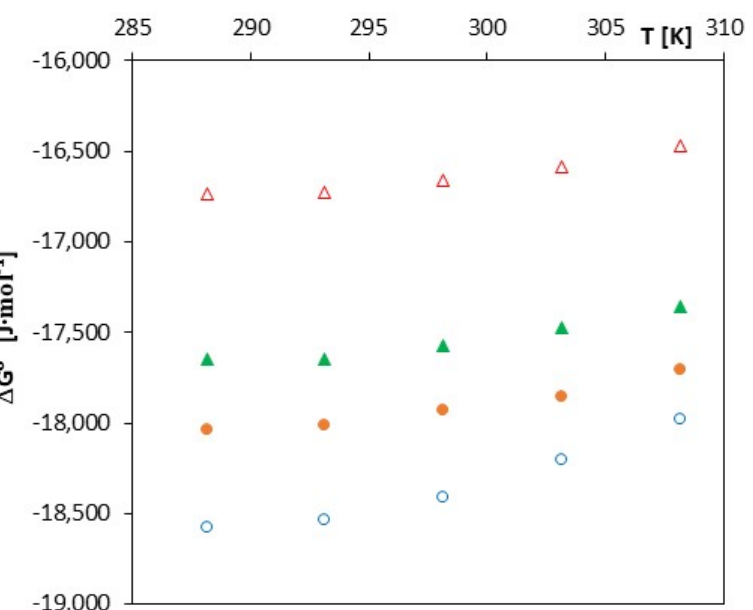
Figure 3. The plots of dependence of the lnK f (dm 3 /mol) formation constant in the T (K) function for α -cyclodextrin with all studied salts: ∆ - trans -cinnamic acid; ▲ - trans-p -coumaric acid; ● - trans - caffeic acid; and ○ - trans -ferulic acid.